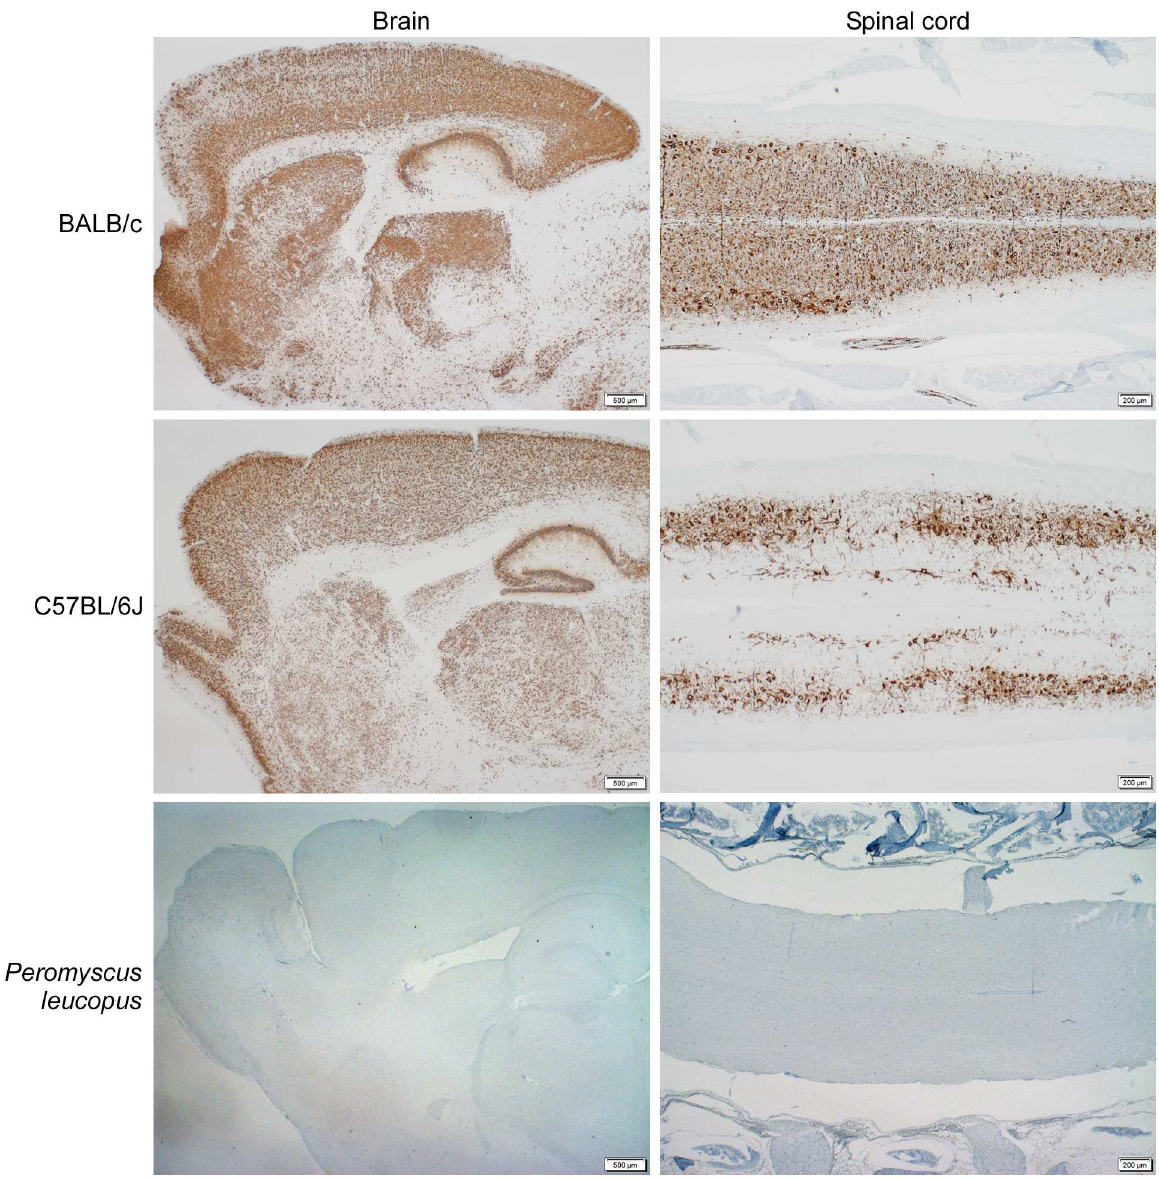
Fig 6. Detection of POWV (+)RNA in the brain and spinal cord by in situ hybridization after i.c. inoculation. Diffuse positivity was observed in the brainsof both BALB/c and C57BL/6mice at 4 or 5 dpi. Positivity in the spinalcord was diffuse in BALB/c mice, but multi-focal in C57BL/6mice. No viral RNA could be visualizedin the brain and spinal cord of P . leucopus mice at 28